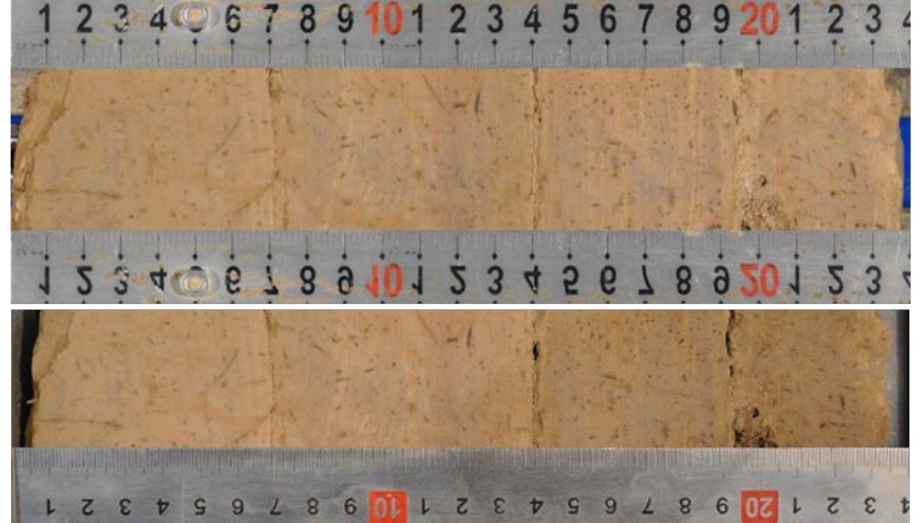
Figure 13. Pores in middle layer, sand layer, and plant root of columnar sample.